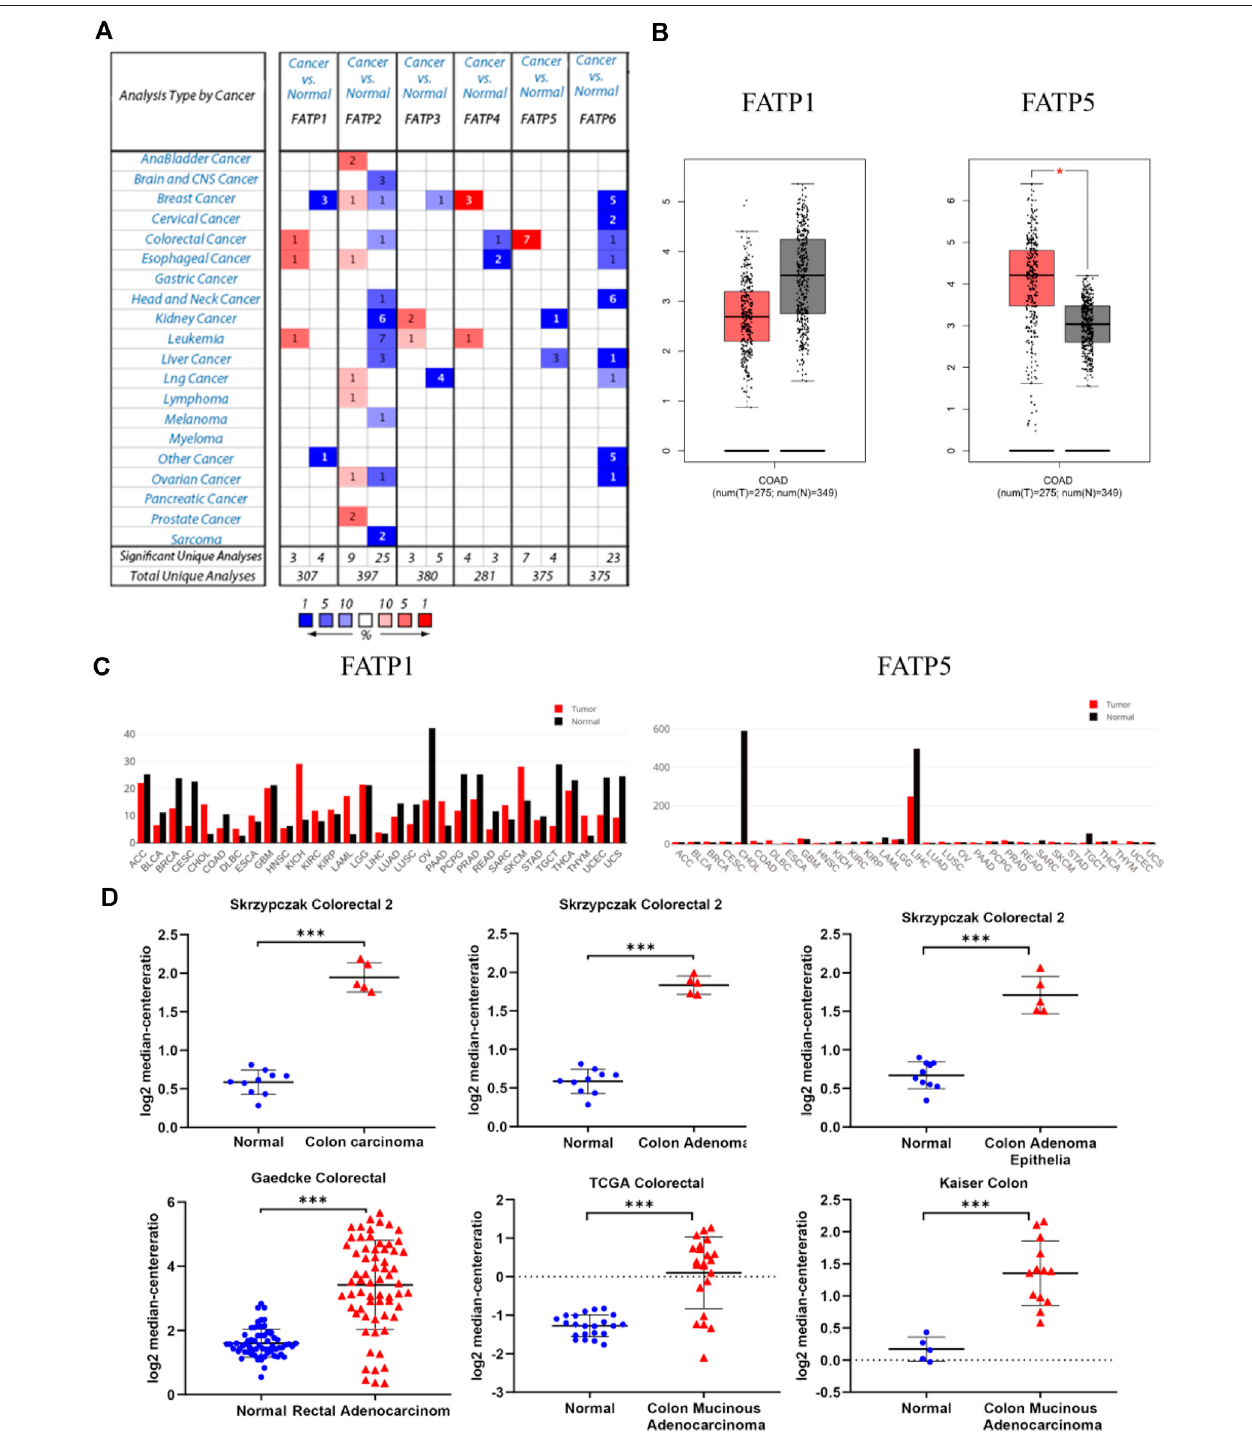
FIGURE 2 | FATP5 mRNA expression was elevated in human colorectal cancer (CRC). (A) Using the Oncomine database, this graph shows the numbers of datasetswithstatisticallysigni fi cantmRNAoverexpression(red)ordownexpression(blue)ofFATPs(cancertissuesvscorrespondingnormaltissues).Thethresholdwas de fi ned with the following parameters: p -value of 1E-4, fold change of 2 and gene ranking of 10%. (B – C) The GEPIA database veri fi ed that FATP5 gene expression was signi fi cantly upregulated in colon cancerFATP1 tissues ( n (cid:1) 275) compared with normal colon tissues ( n (cid:1) 349), * p < 0.05. (D) The Oncomine database analysis of FATP5 gene expressions in different subtypes of colorectal cancer, *** p < 0.001.